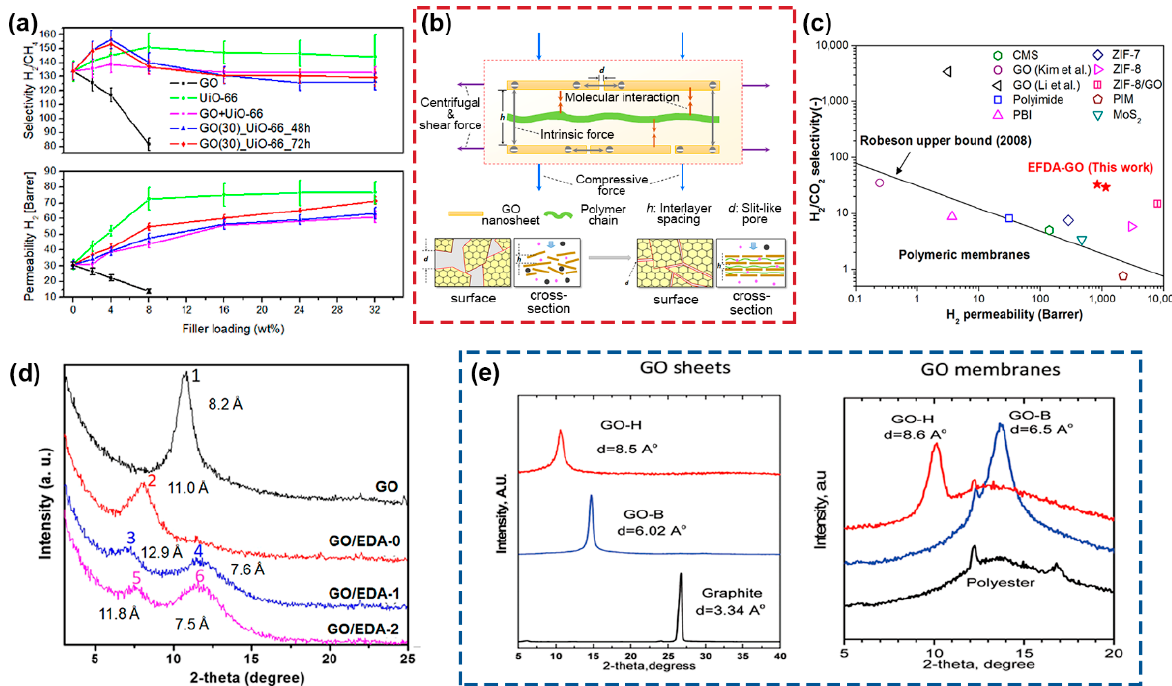
Figure 9. ( a ) Performance of mixed-matrix membranes containing graphene oxide (GO), showing GO, UiO-66 and UiO-66/GO effect on H 2 permeability and H 2 /CH 4 selectivity in Matrimid ® 5218 polymer matrix. Reprinted with permission from ref. [135]. Copyright 2017 Elsevier. ( b ) An illustration of the GO-laminated membrane intercalated by polyethyleneimine and ( c ) its H 2 /CO 2 performance with reference to the 2008 Robeson upper bound. Reprinted with permission from ref. [139]. Copyright 2016 American Chemical Society. ( d ) Comparison of the XRD profile and d -spacing between GO membranes and GO membranes intercalated with ethylenediamine (EDA). Reprinted with permission from ref. [140]. Copyright 2018 Elsevier. ( e ) Effects of two different GO synthesis methods (GO-H, GO synthesized by modified Hummer’s method and GO-B, GO synthesized by modified Brodie’s method) on the d -spacing of the GO sheets and laminated membranes. Reprinted with permission from ref. [141]. Copyright 2019 Royal Society of